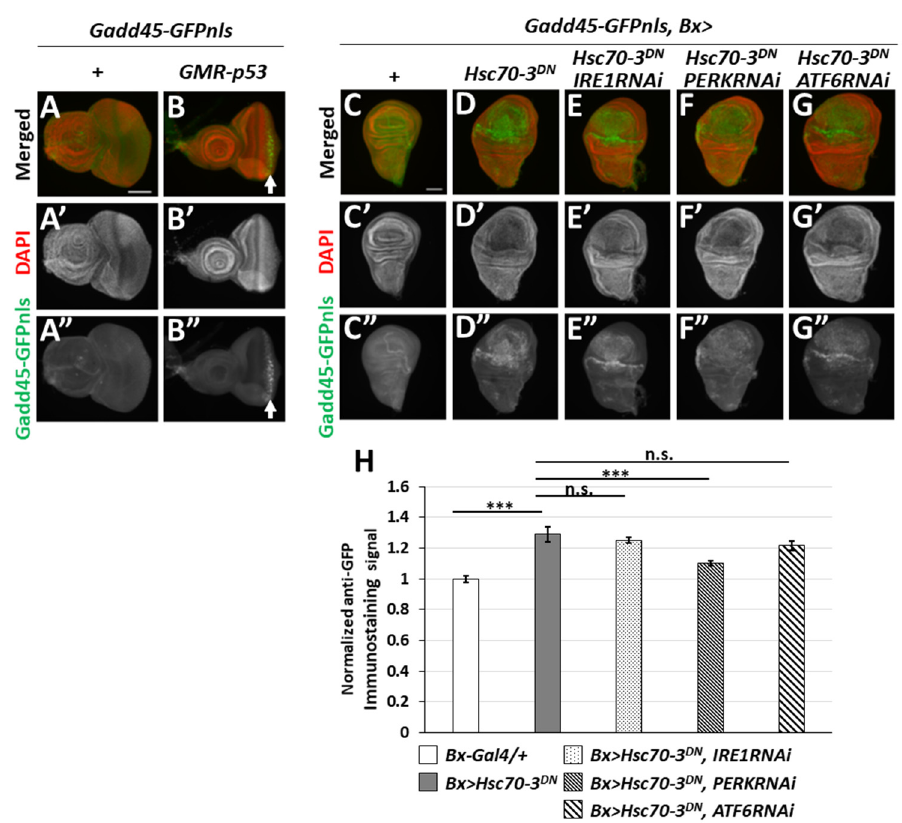
Figure 2. p53-Dependent Gadd45 expression and a requirement of three ER stress sensors for ER-stress induced Gadd45 expression in wing imaginal discs. ( A – B ) Induction of Gadd45-GFP (green in ( A , B ), white in ( A ”, B ”), arrow in ( B , B ”)) generated by p53-dependent cellular stress response. Red in ( A , B ) (white in ( A ’, B ’)): DNA staining. ( A – A ”) A control eye imaginal disc ( Gadd45-GFP ). ( B – B ”) An eye imaginal disc expressing p53 in after a morphogenic furrow of eye imaginal discs under the GMR promoter. Scale bar: 100 μ m ( C – G ). Fluorescent micrographs of wing imaginal discs harboring Gadd45-GFP reporter. DAPI staining (red). ( C – C ”) A Control wing disc ( Bx-Gal4/ +; Gadd45-GFP/+ ). ( D – D ”) A wing disc having Hsc70-3 DN expression in the wing pouch region ( Gadd45-GFP, Bx > Hsc70-3 DN ). ( E – E ”) A wing disc having Hsc70-3 DN expression and IRE1 depletion ( Gadd45-GFP, Bx > Hsc70-3 DN , IRE1RNAi ). ( F – F ”) A wing disc having Hsc70-3 DN expression and PERK depletion ( Gadd45-GFP, Bx > Hsc70-3 DN , PERKRNAi ). ( G – G ”) A wing disc having Hsc70-3 DN expression, ATF6 depletion ( Gadd45-GFP, Bx > Hsc70-3 DN , ATF6RNAi ). Scale bar: 100 μ m. ( H ) Quantification of GFP levels in wing discs. The intensity of Gadd45-GFP fluorescence in each wing imaginal disc expressing Hsc70-3 DN and/or dsRNA against each of three ER stress sensors as calculated and normalized to that of the control, set to 1.0 ( Bx-Gal4/+ ) ( n > 21, *** p < 0.001 , n.s.: not significant, Student’s t -test). Error bars represent SEMs.